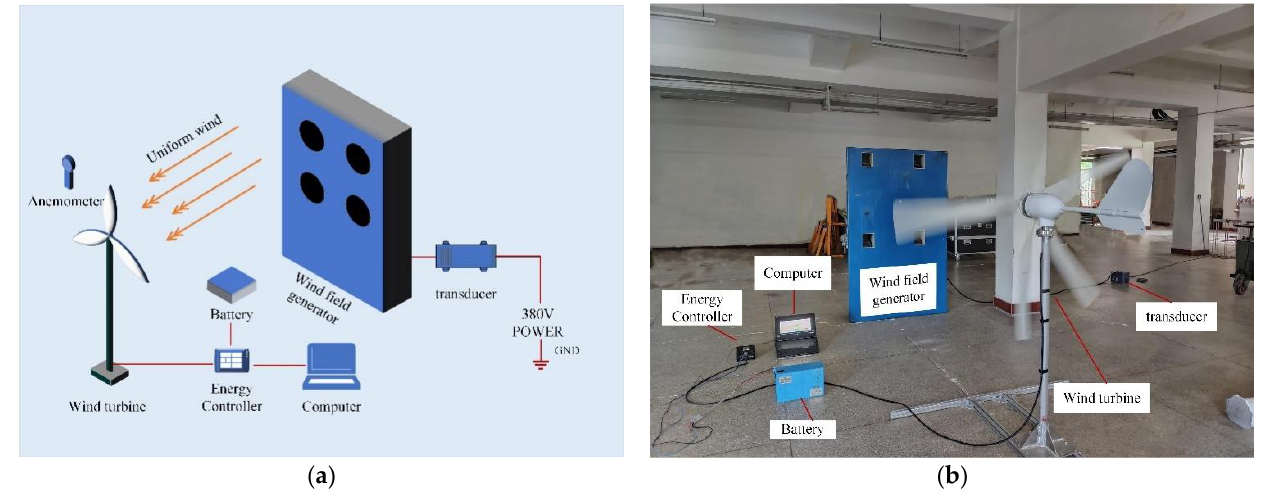
Figure 3. Wind field power generation test. ( a ) Schematic diagram of the experiment, ( b ) actual diagram of the experiment. Through the experiment, we got Table 1 and Figure 4. Table 1. The power and power coefficient C p 1 of the wind turbine at different wind speeds.